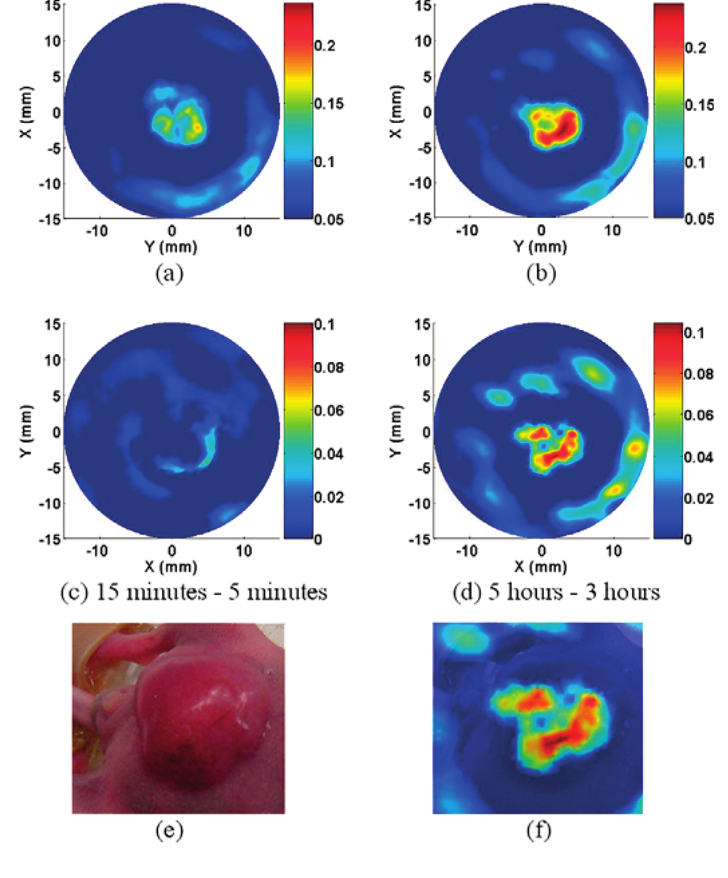
Figure 1. PAT images of tumor at 5 min ( a ) and 5 h ( b ) following tail vein injection of gold nanoparticles; ( c ) and ( d ) are the subtraction PAT images of tumor following tail vein injection of gold nanoparticles demonstrating increased accumulation of nanoparticles in tumor at 5 h. The color scale (right) represents optical absorption of tissue (arbitrary units); ( e ) is gross picture of tumor in mouse and ( f ) is the fusion image of gross photo and subtraction PAT image, 5 h following tail vein injection. (Reprinted from reference [22]. Copyright with permissionfrom © 2009 IOP Publishing